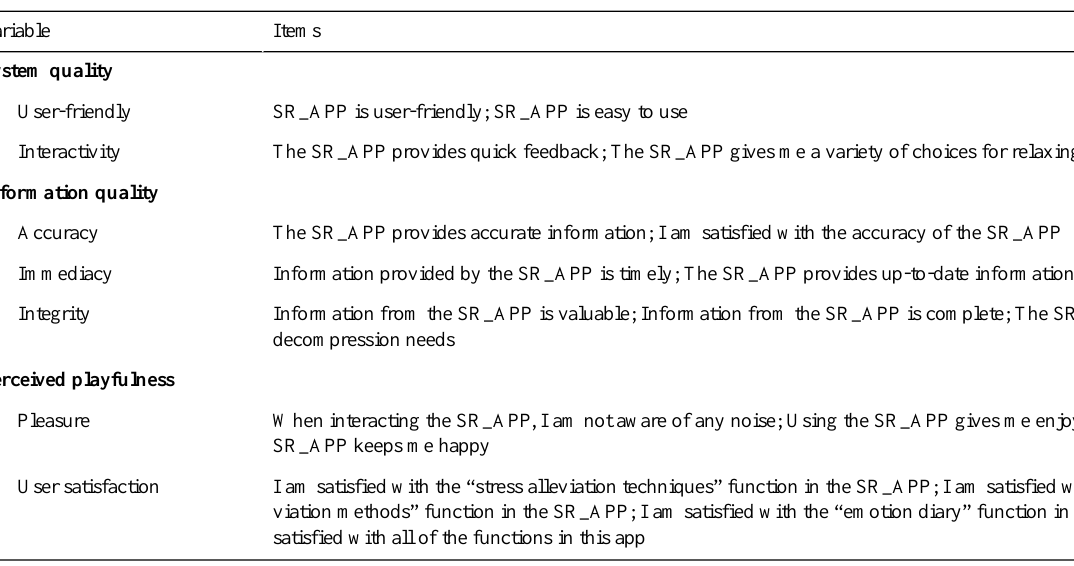
Table 1. The items for evaluating the